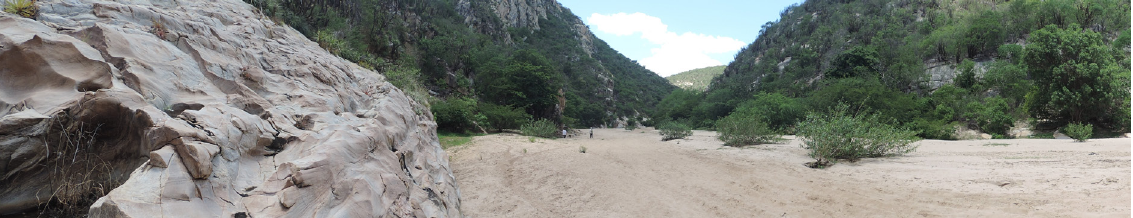
Figure 3. The river erosion processes were responsible for modeling the canyons found in the Cânions dos Apertados Geosite, an example of a geodiversity regulating service. Photo: Matheus